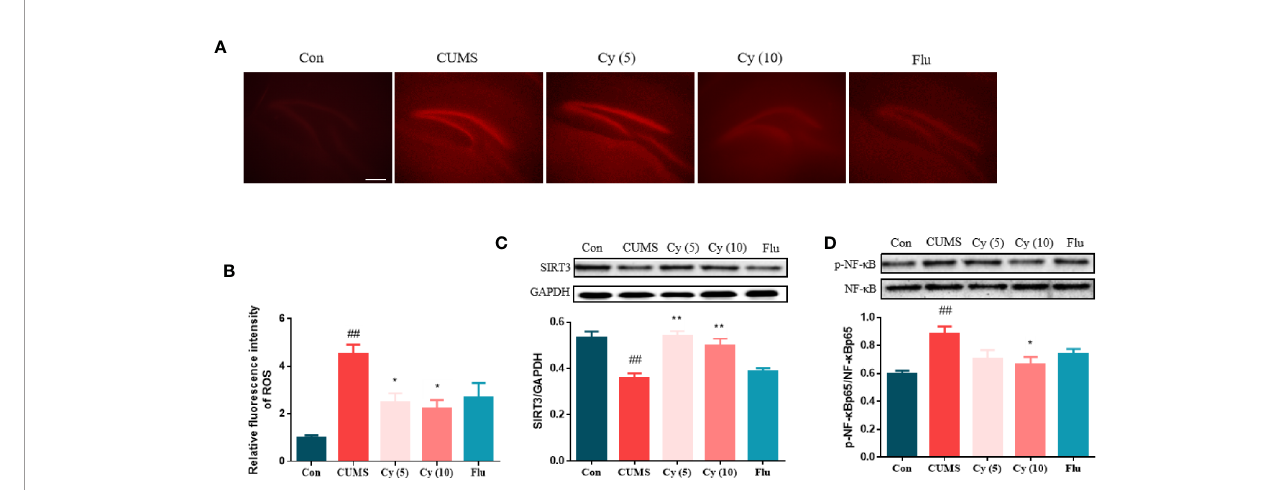
FIGURE 2 | ROS production and protein levels of SIRT3 and NF- k B in the hippocampus. Hippocampal ROS production was increased in mice receiving CUMS challenge (A, B) . Meanwhile, upregulated SIRT3 expression (C) and downregulated p-NF- k B level (D) was detected in the hippocampus of CUMS mice. Nonetheless, the SIRT3/ROS/NF- k B signaling was successfully restored by Cy intervention. Data are represented as mean ± SEM. ## p < 0.01 vs. Con group. * p < 0.05 and ** p < 0.01 vs. CUMS group.